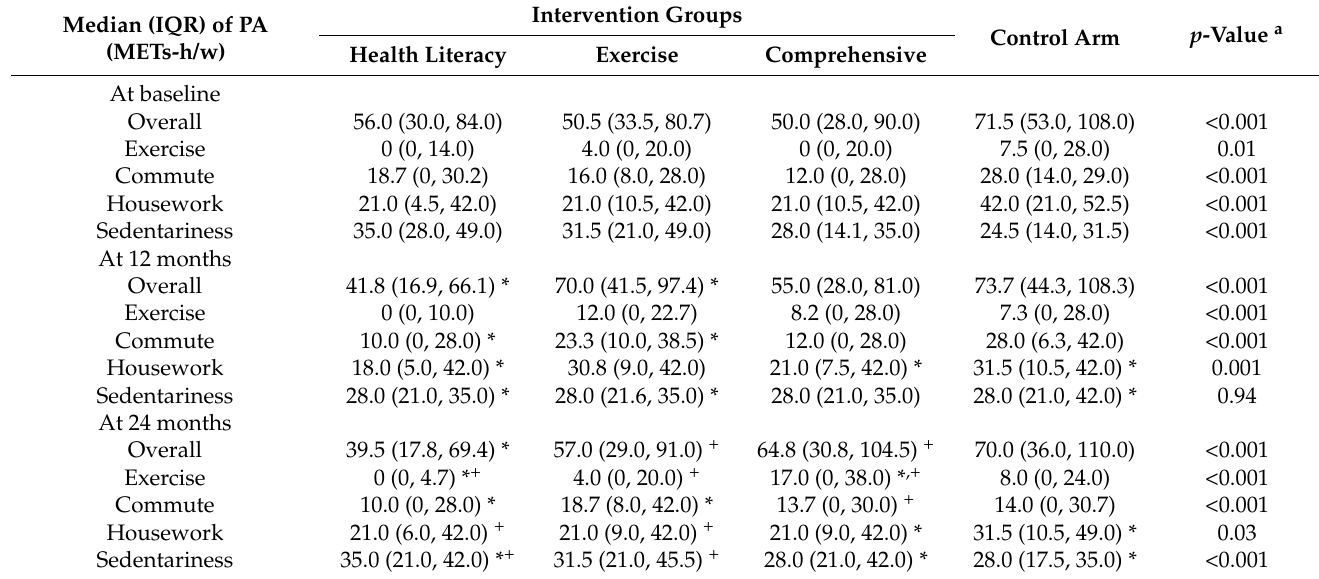
Table 1. Physical activity (PA) levels during the study period among diabetes patients in four arms. Median (IQR) of PA